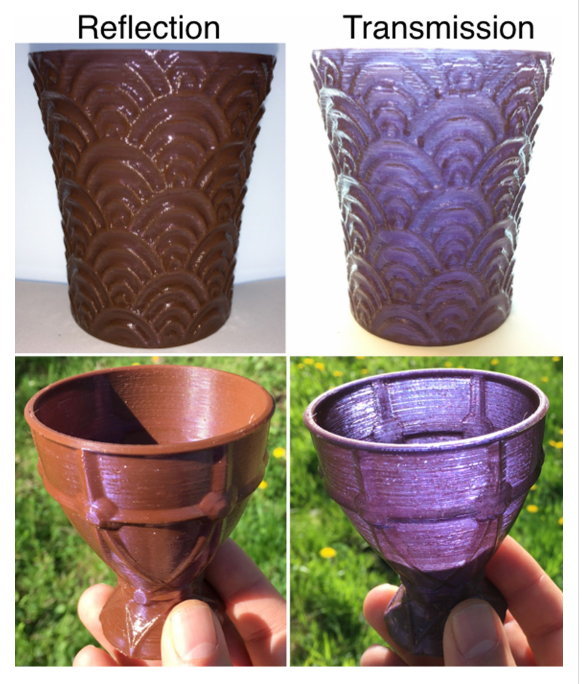
Figure 3: 3D-printed cups using AuNP–PVA material showing the dichroic effect in artificial and